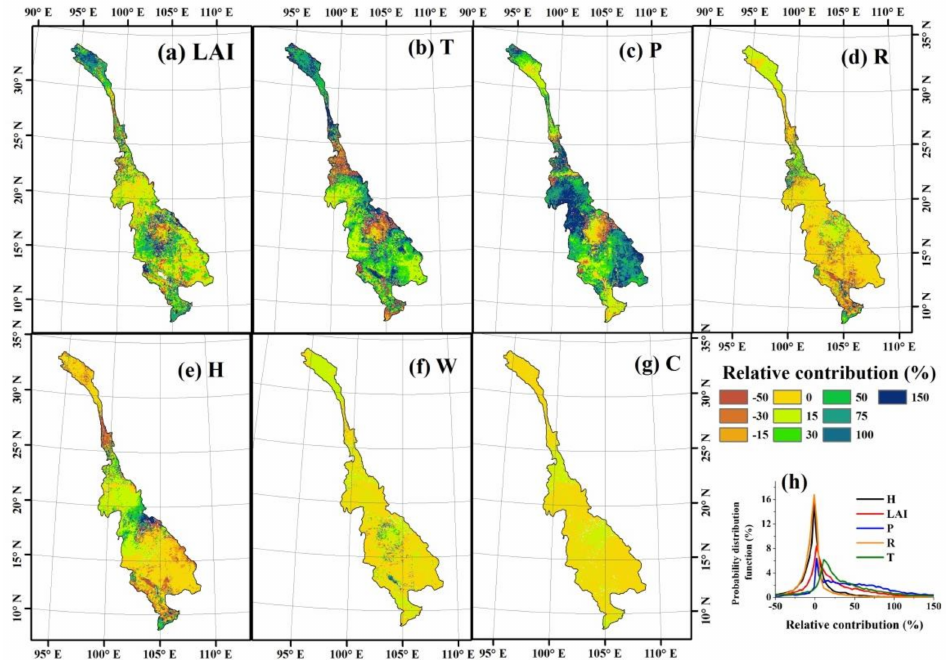
Figure 8. Spatial patterns of the relative contributions of the variation of ( a ) LAI, ( b ) temperature, ( c ) precipitation, ( d ) radiation, ( e ) vapor pressure, ( f ) wind speed, ( g ) atmospheric CO 2 concentration variation to ET a and ( h ) probability distribution function of relative contributions of the main climatic variables and LAI changes to ET a trends in Mekong River